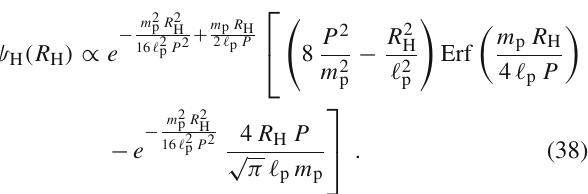
Fig. 4 Probability density P H ( R H ) = 4 π R 2 zon to be located on the sphere of radius r = R H , for E = 1 . 2 1 . 7 m p (dotted line), E = 1 . 6 √ E = 2 2 m p (cid:11) 2 . 8 m p (continuous line) for two overlapping shells withvanishingmeanradius.Curvespeakatvalueslargerthan R H ∼ 2